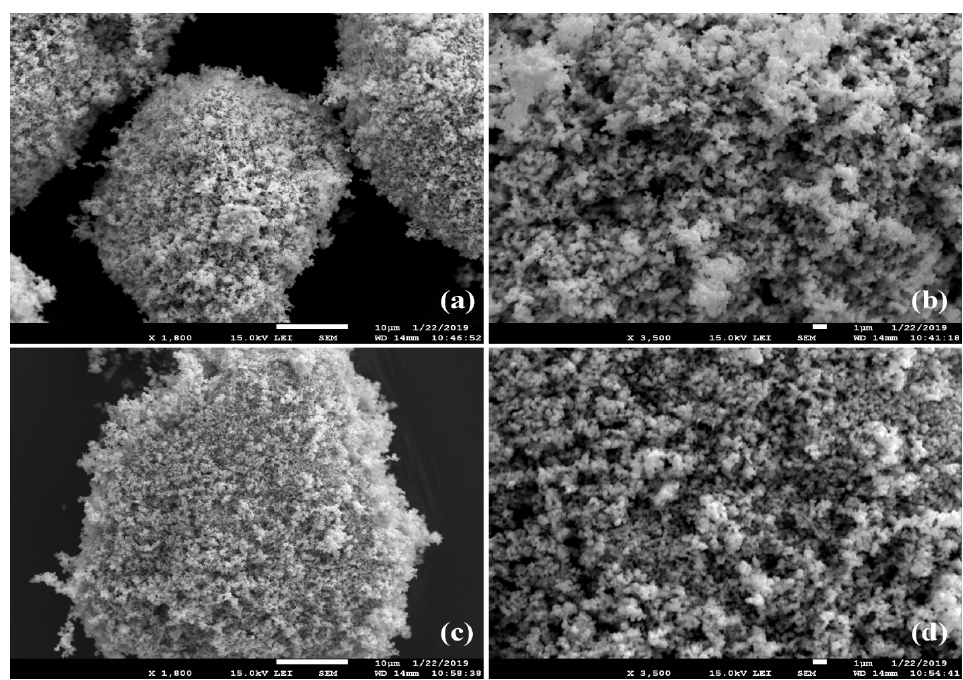
Figure 1. SEM images of binary structured ( a , b ) ZS–1, and ( c , d ) ZT–1 catalysts at the same magnifications ( a ) and ( c ) ×1800 and ( b ) and ( d ) ×3500 for comparison.